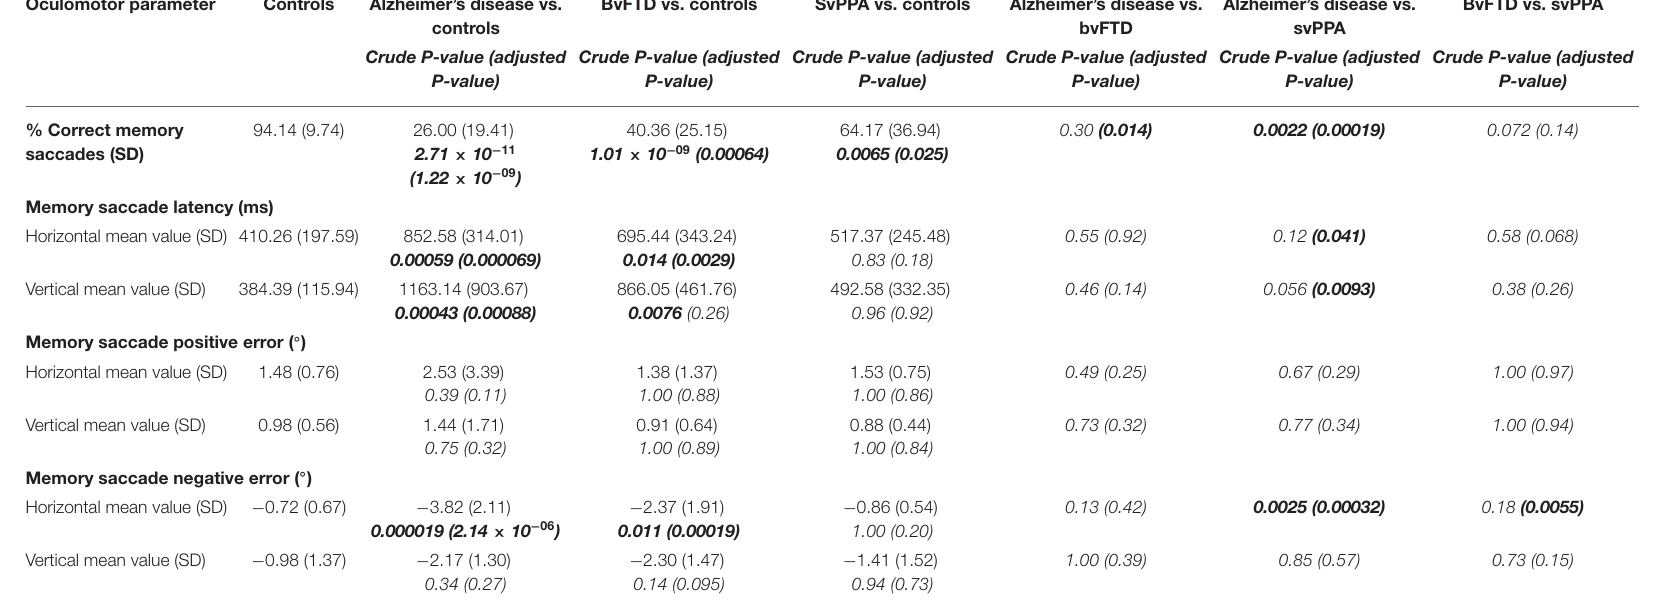
TABLE 4 | Volitional saccades: Memory saccade